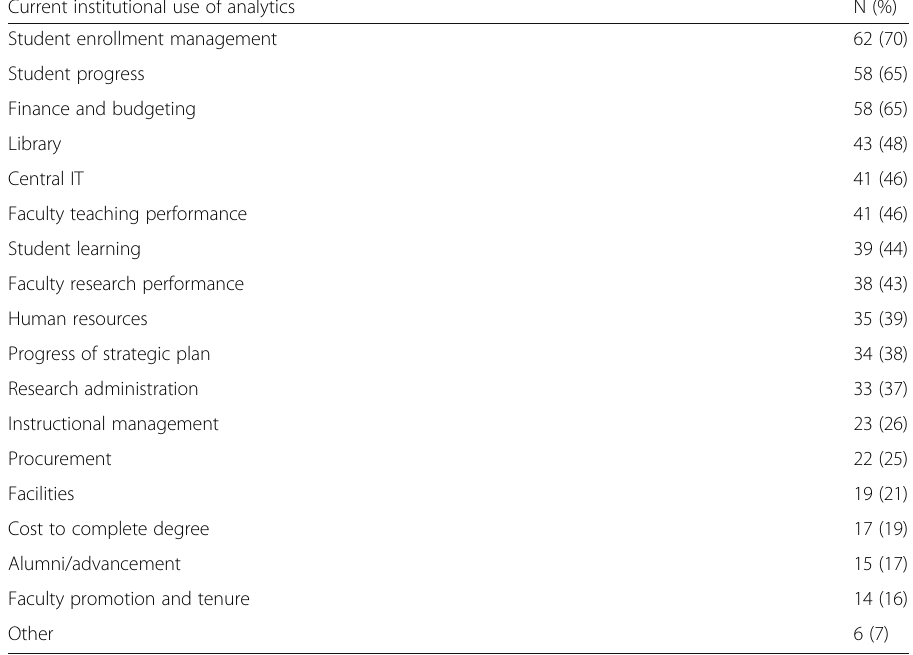
Table 4 Use of analytics in institutions Current institutional use of